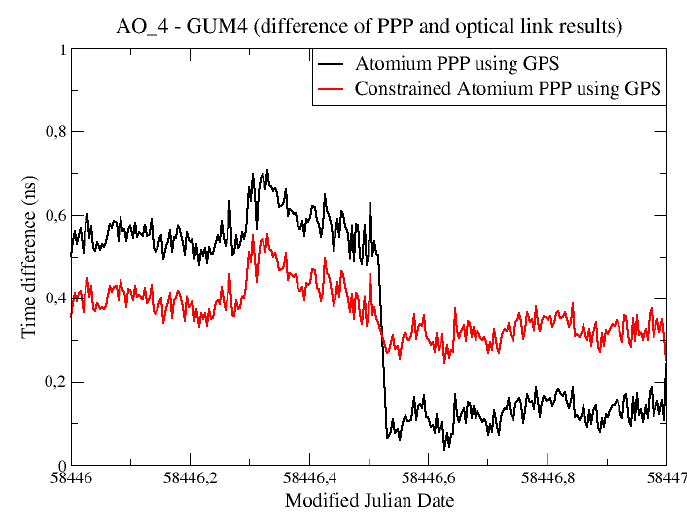
Figure 11. “PPP—OPT” experiments to evaluate constrained PPP.